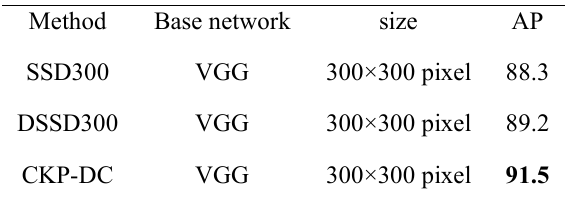
Figure 10. Results of SSD and CKP-DC on